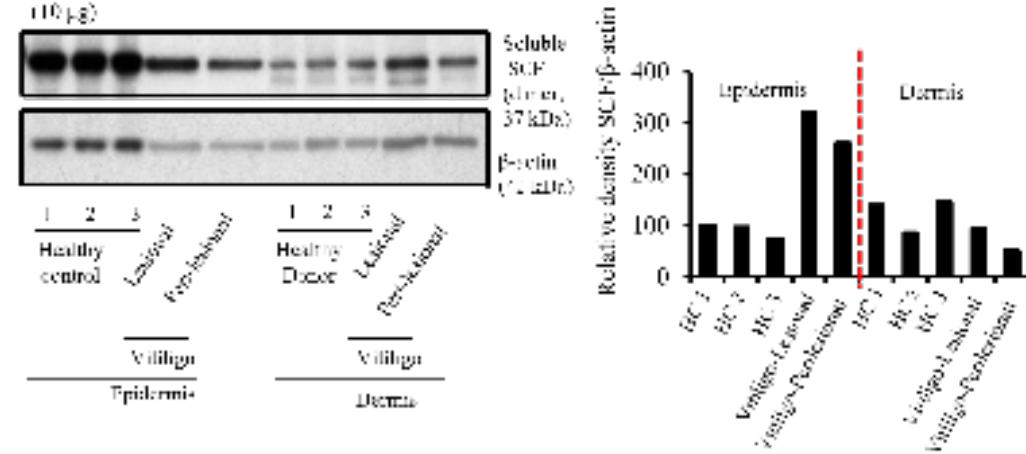
Figure 4. Elevated SCF expression was observed in epidermis accompanied with increased mast cell infiltration in vitiligo. Skin sections from lesion site and leading edge of vitiligo were stained with anti-tryptase in green and anti- pre-melanosomal protein (Pmel17) in red, and epidermal mast cells were examined by immune-electron microscopy using anti-tryptase staining (A). Protein extracted from lesional and perilesional skin of vitiligo were applied to western blotting analyses, the expression of SCF was detected by anti-SCF antibody (B). The red arrowheads in (A) indicate the epidermal mast cells. BMZ: basement membrane zone; HC: healthy control. Scale bar: 100